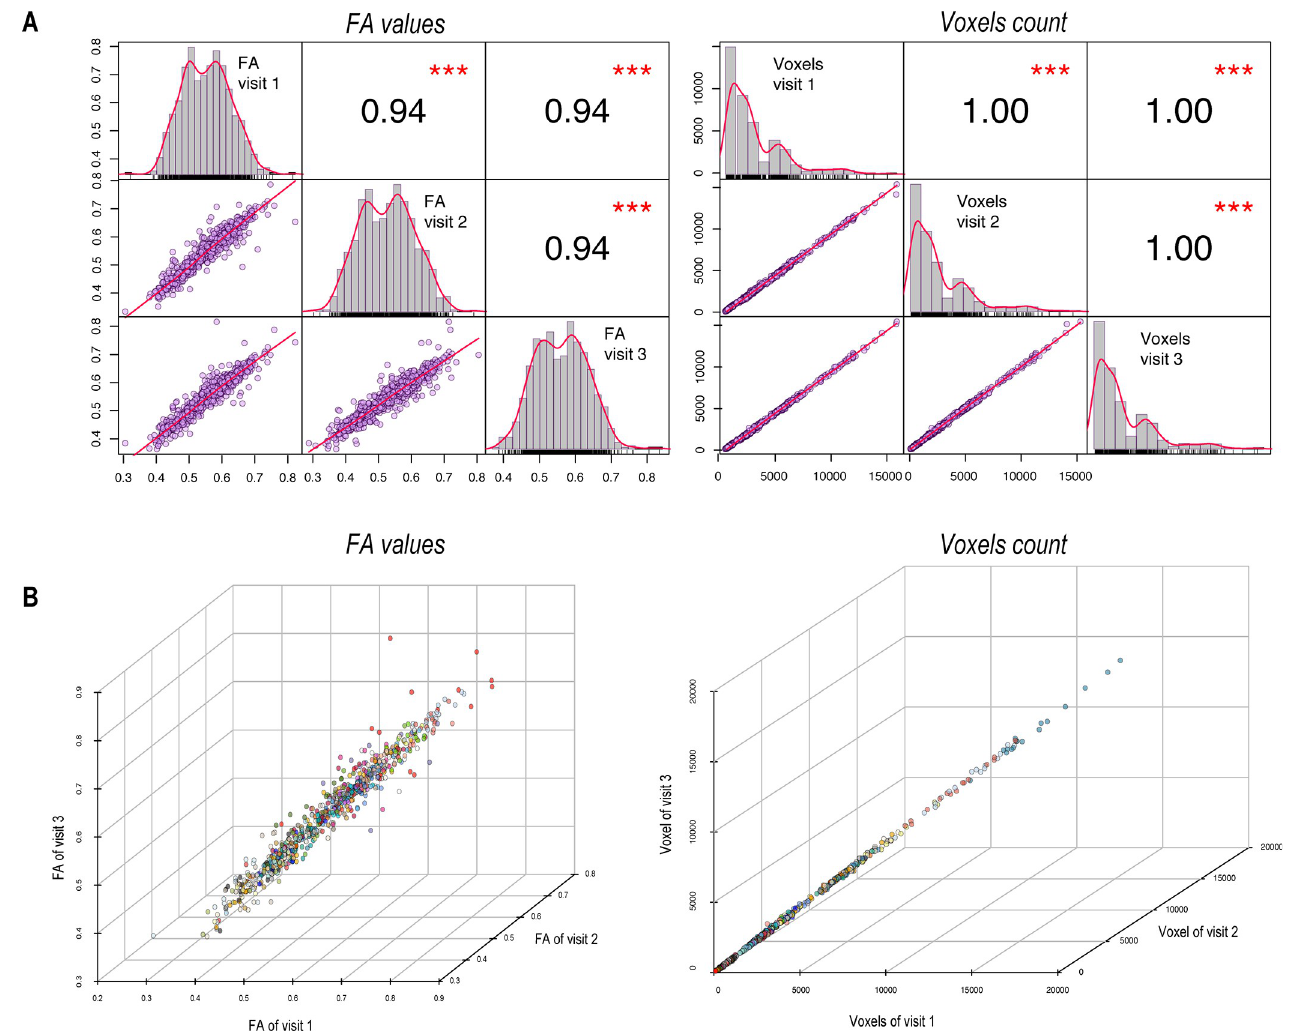
Fig 7. Test-retest correlation across subjects and visits. (A) Pairwise correlation matrix of mean FA values and voxel count per tract per subject. Upper right values represent correlation coefficients r, histogram represent mean FA and voxel count distributions and scatterplot represent pairwise correlation of data points. P-values: ��� < 0.01. (B) 3D correlation plot of mean FA value and number of voxels for all three visits per tract, per subject. Each color represents a different tract, for all 47 tracts of the JHU atlas.